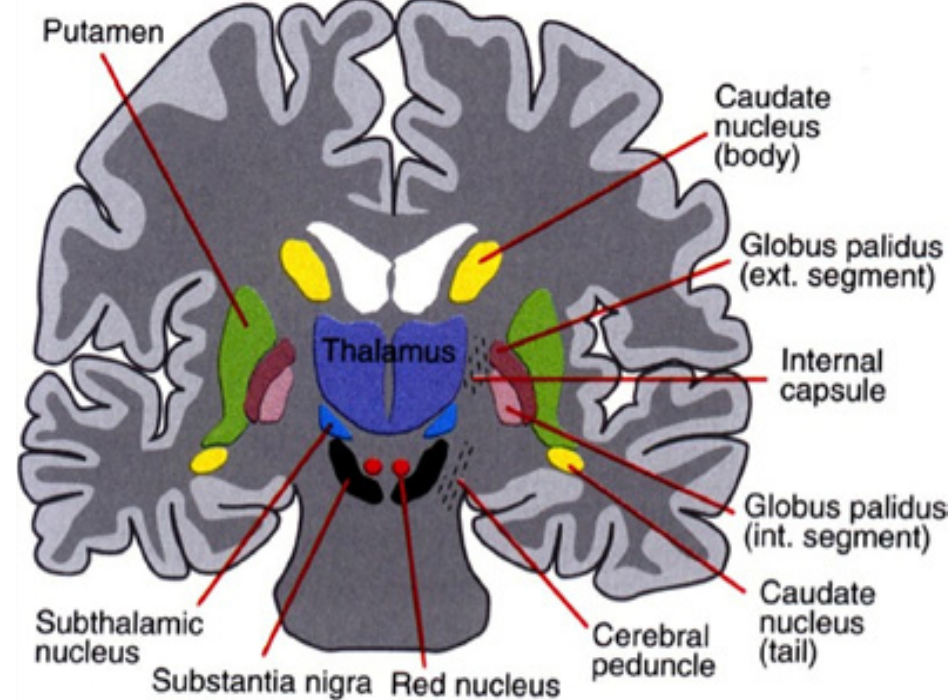
Figure 2. The basal ganglia that clinically includes sub-thalamic nucleus and substantia nigra whose component structures are highly interconnected (after Leisman, G., Braun-Benjamin, O., and Melillo, R. (2014). Cognitive-motor interactions of the basal ganglia in development. Frontiers in systems neuroscience , 8 , 16. with permission ).